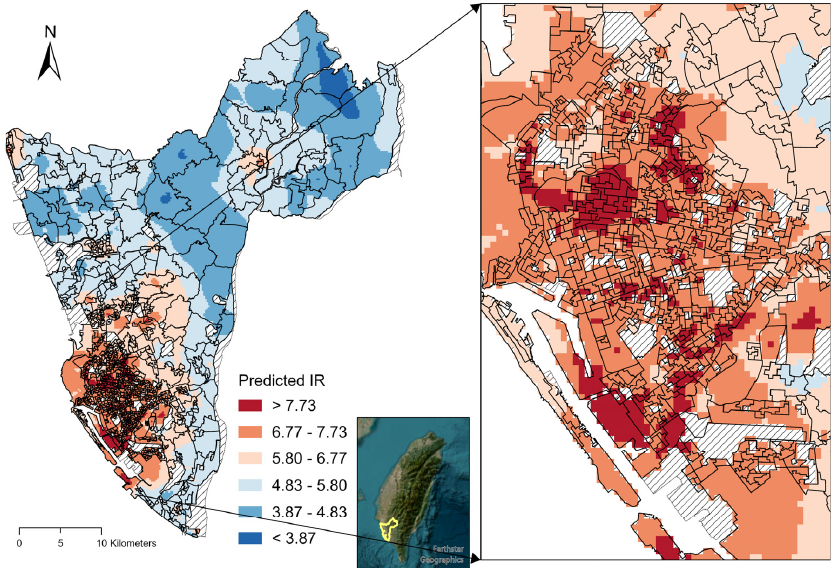
Figure 4. Predicted dengue incidence rates (smoothed by ordinary kriging) in the second-level dissemination areas in Kaohsiung City, Taiwan. The right panel shows the zoomed-in view of the high- risk zones in the metropolitan region.